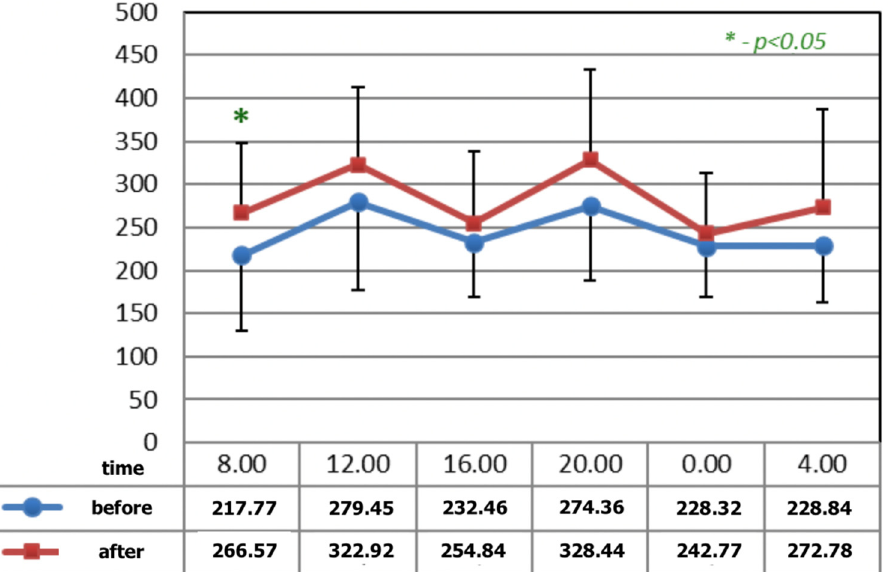
Figure 2. The circadian concentrations (ng/mL) of serotonin before and after the completion of M2 P2 magnetic stimulation. * statistical significance.